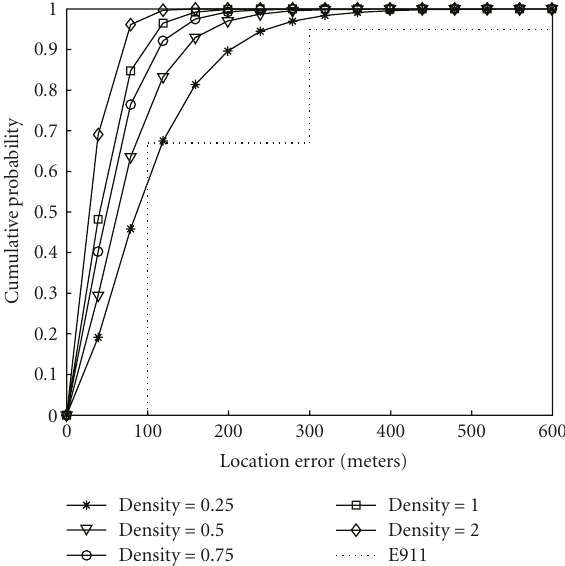
Figure 11: REWL location error CDF by node density for 5.8GHz.